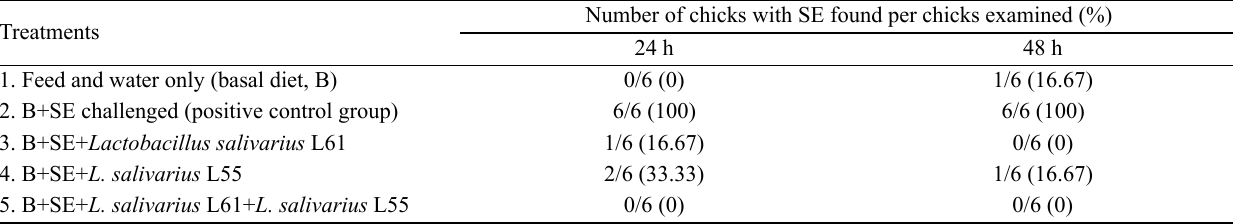
Number of chicks with SE found per chicks examined (%)